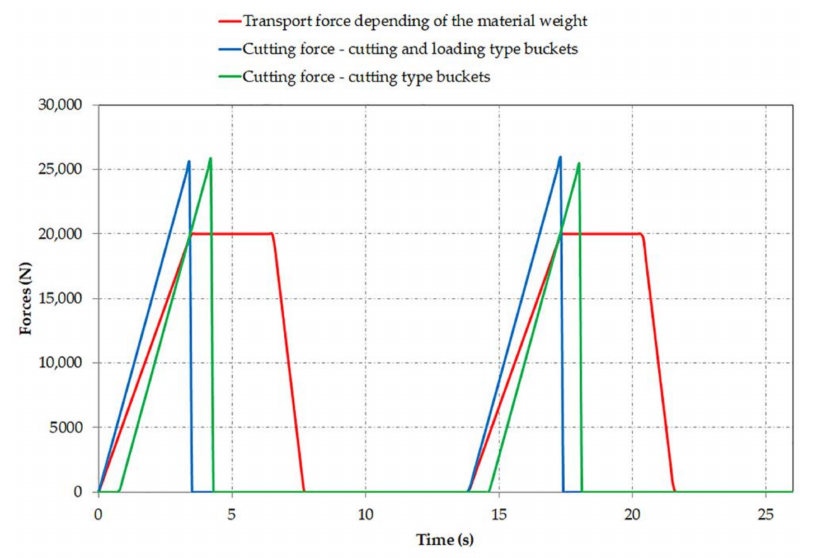
Figure 4. Time variation of the cutting force and transport force depending on the material. Figure 5a–c show the variation diagrams of the forces for all buckets for the entire simulation period.